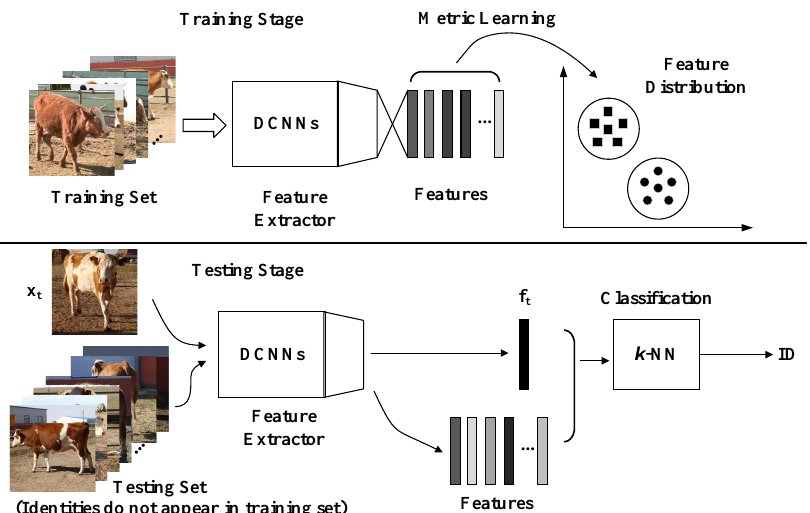
Figure 1. Pipeline of the cattle identification model training and testing under the open-set identifica- tion protocol. In the training stage, the deep metric learning methodology is utilized to supervise the learning process to extract separable and discriminative features. In the testing stage, the feature is extracted using DCNNs and classified by the k -NN